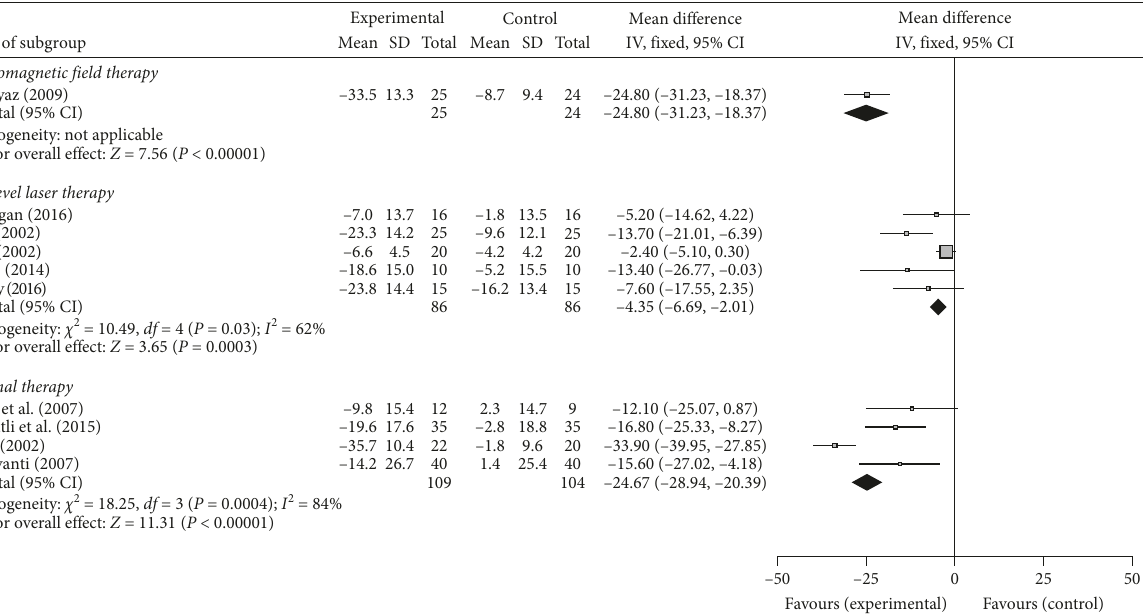
Figure 4: The mean difference and 95% CI values on the FIQ for the physical-agent